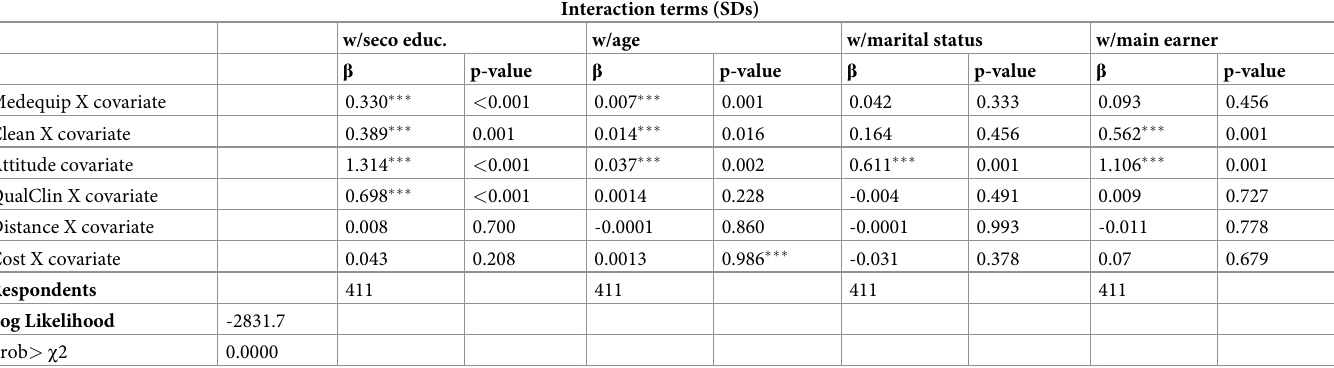
Table 6. Mixed logit model results with interactions for a discrete choice experiment addressing facility preferences for delivery among women, in a peri-urban set- ting in